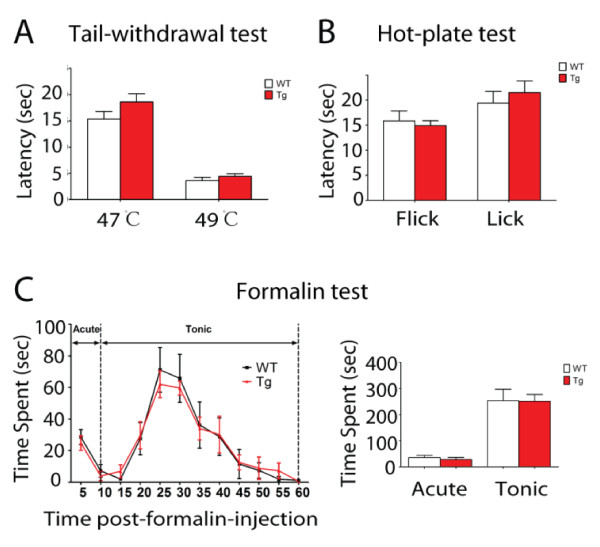
Normal cutaneous pain sensitivity in transgenic mice to thermal and inflammatory stimulation. A-B. Comparison of thermal sensitivity in wild type (WT) and transgenic mice (Tg) by cutaneous application of thermal stimulation. No significant difference was detected between the two groups in tail withdrawal test (A) at 47°C and 49°C and in hot plate test (B) at 53°C (mean ± s.e.m, n = 7-11). C. The Tg mice displayed equivalent licking/biting behavior in both the acute and tonic phases in 5% formalin test (mean ± s.e.m, n = 7-9). The acute phase of the formalin test was defined as 0-10 min after injection and the tonic phase as 10-60 min after injection.